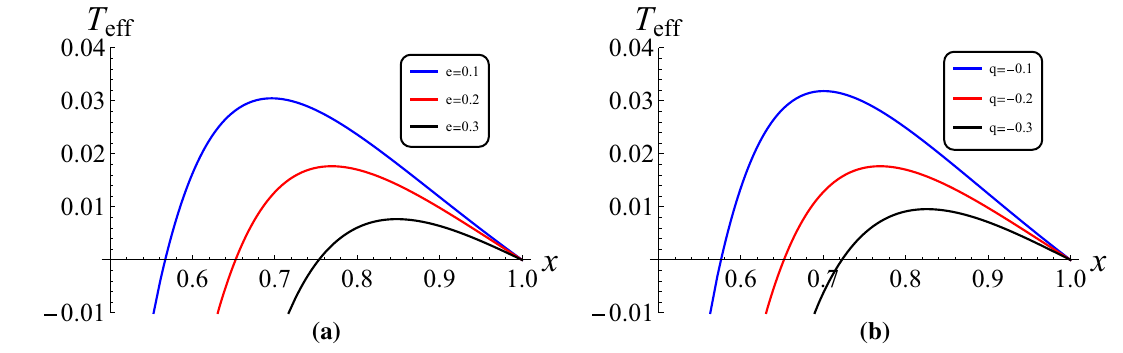
Fig. 6 The behavior of the effective temperature as a function of x . a For different e ( q is fixed at − 0.2), b for different q ( e is fixed at 0.2)